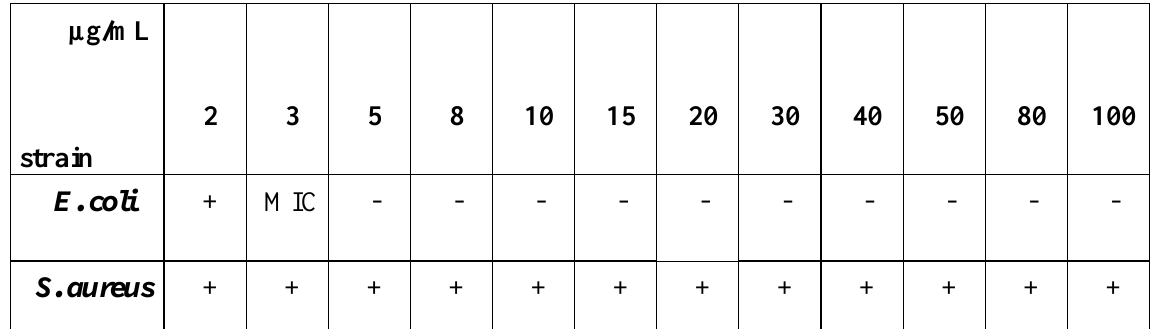
Table 2. Strain sensitivity towards cyclosulfamide